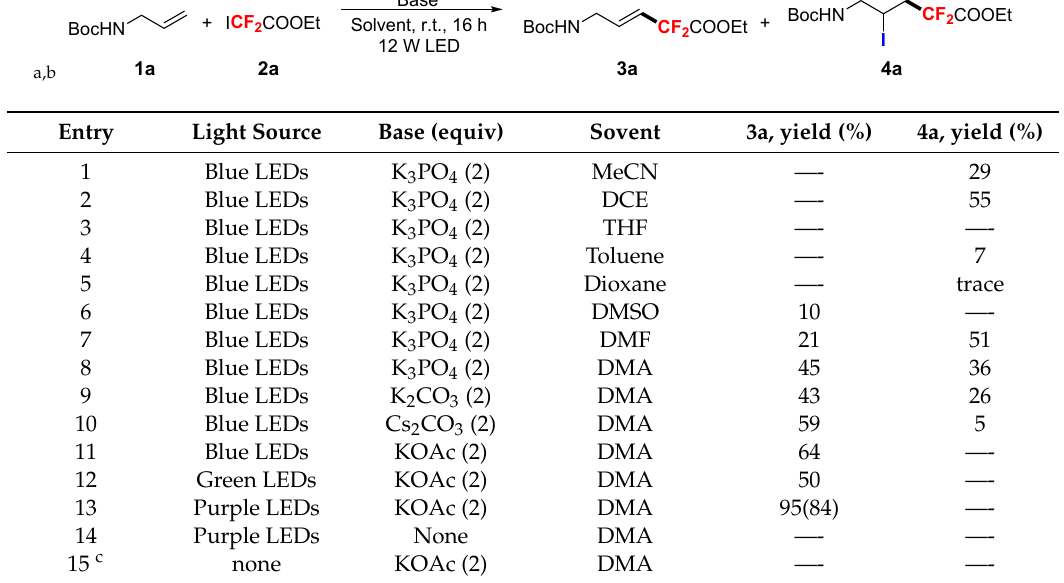
Table 1. Representative results for optimization of visible light-mediated reaction of 1a and 2a .